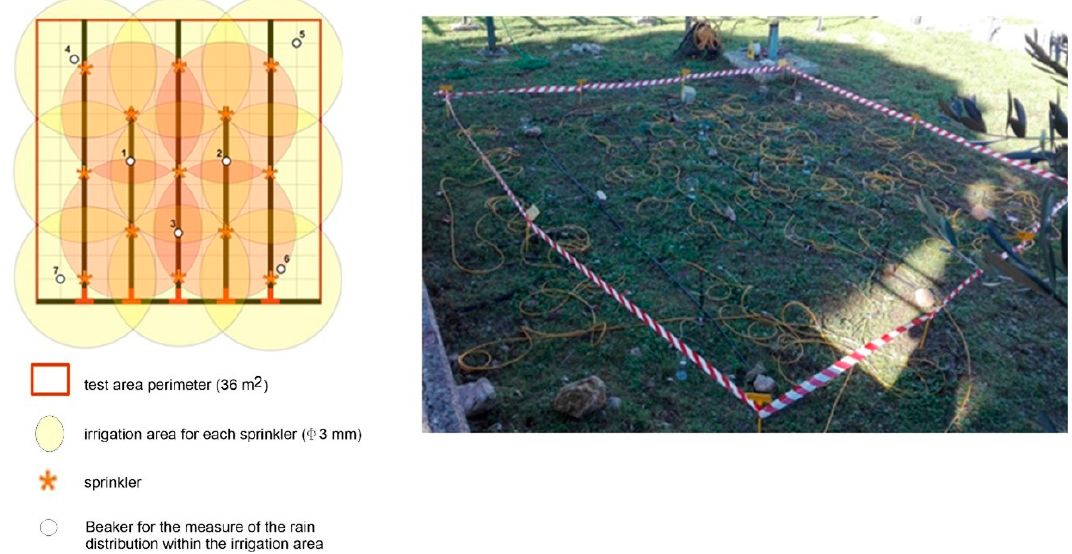
Figure 2. Experimental set up for the artificial rain test and for ERT